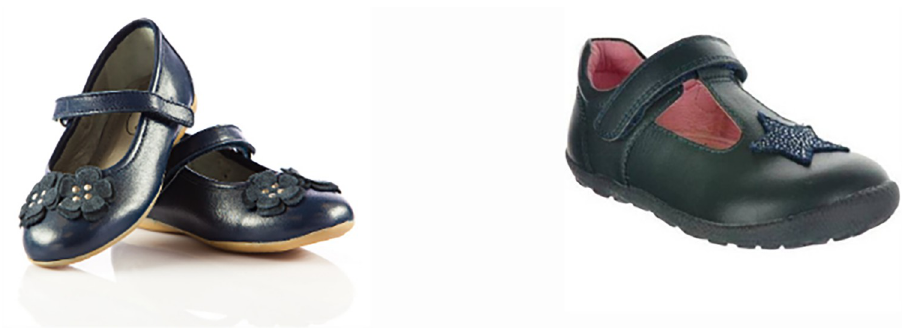
Fig 1. Footwear style